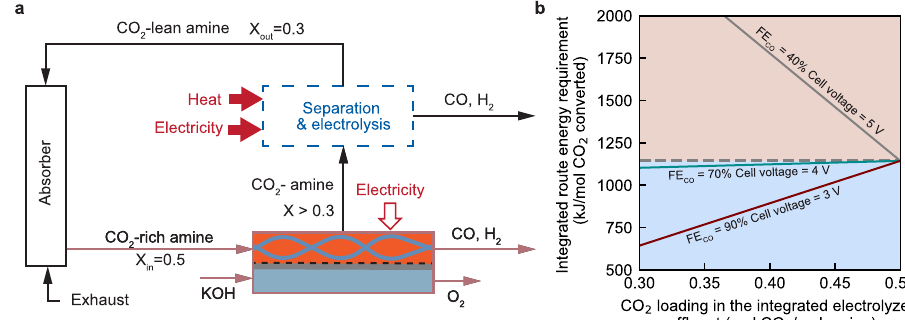
Fig.4|Effectofthesingle-passconversionoftheintegratedelectrolyseronthe overall energy ef fi ciency.a A schematic illustration oftheintegrated route where the electrolyser is unable to recover the capture media to the lean loading state. The separation and electrolysis process is symbolic process highlighted with a dashed box to regenerate the capture medium to the lean loading state. X repre- sentstheCO 2 loadinginthecapturemedium,withaunitofmolCO 2 permolamine molecule. b The energy comparison of the integrated route based on baseline